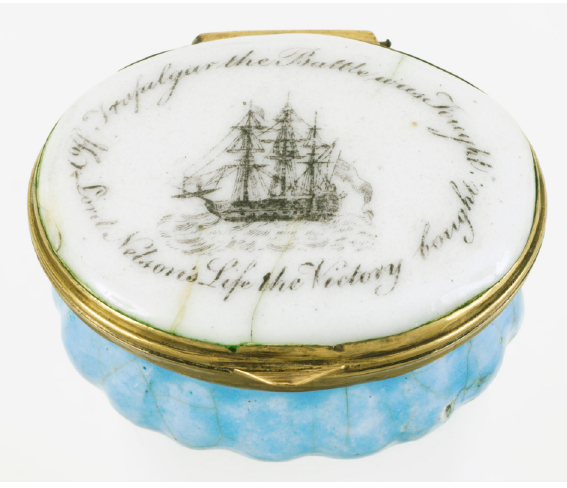
Figure 2: Oval patch box (Object ID OBJ0042) © National Maritime Museum, Greenwich,